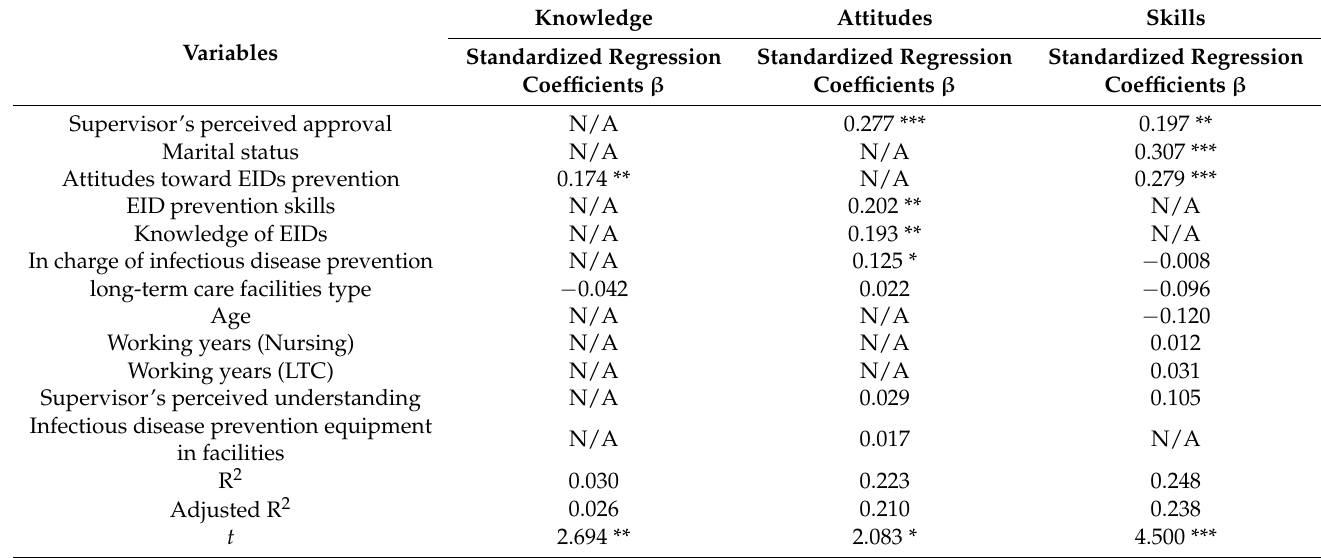
Table 5. Critical factors affecting the EID prevention competency of nurses in long-term care facilities ( N =